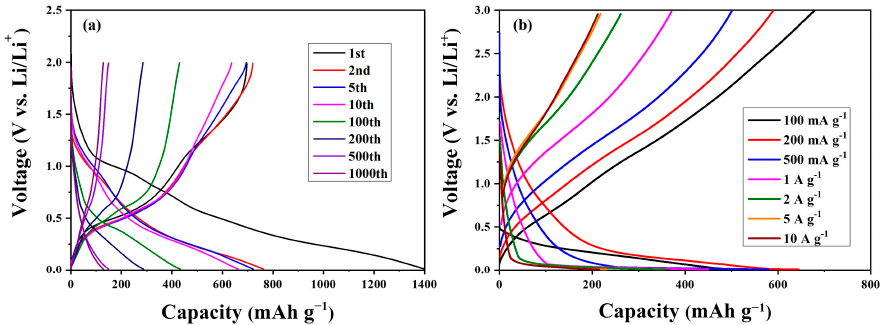
Figure 9. The charge–discharge pro fi les of the SnO 2 -CNFi nanocomposite at ( a ) 100 mA g − 1 and at ( b ) various current densities. ( b ) various current